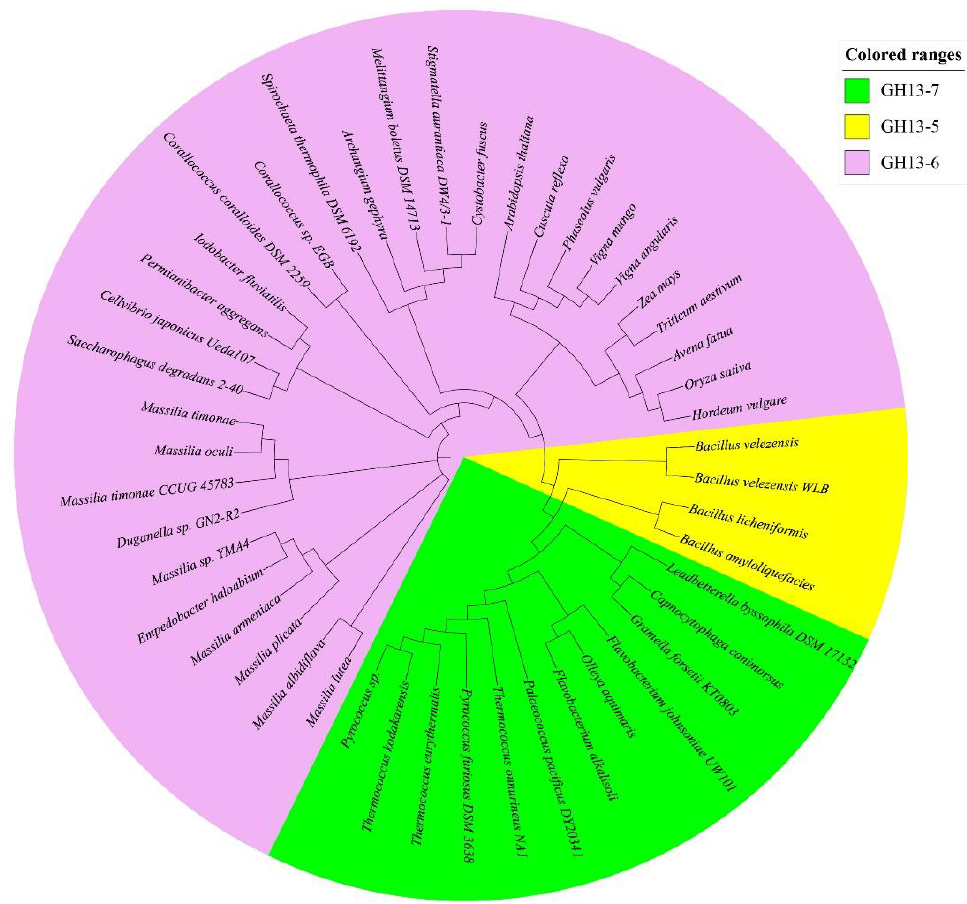
Figure 5. Phylogenetic analysis result of BvAmylase protein. Clustal W in MEGA X was used to make alignment, and the Neighbor-Joining method was used to construct the Phylogenetic tree with bootstrap = 1000. Purple, yellow, and green denote GH13-6, GH13-5, and GH13-7 families separately. The accession numbers are Bacillus velezensis (MW822009), Bacillus velezensis FZB42 (WP_095273266.1), Massilia sp. YMA4 (AXA90592.1), Empedobacter haloabium (WP_147953147.1),